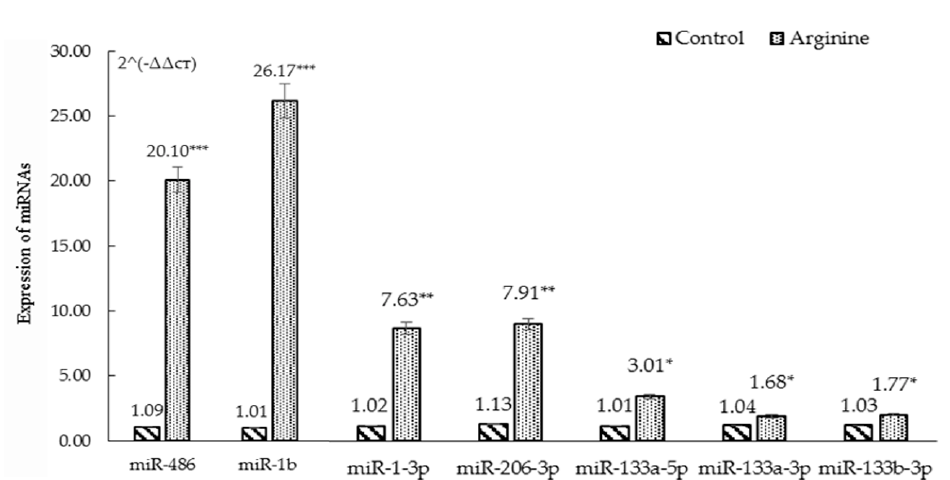
Figure 4. RT-PCR verification of differential expression of miRNAs screened by high throughput sequencing analysis (FC < 0.5 or FC > 2). * p < 0.05, ** p < 0.01, *** p < 0.001.